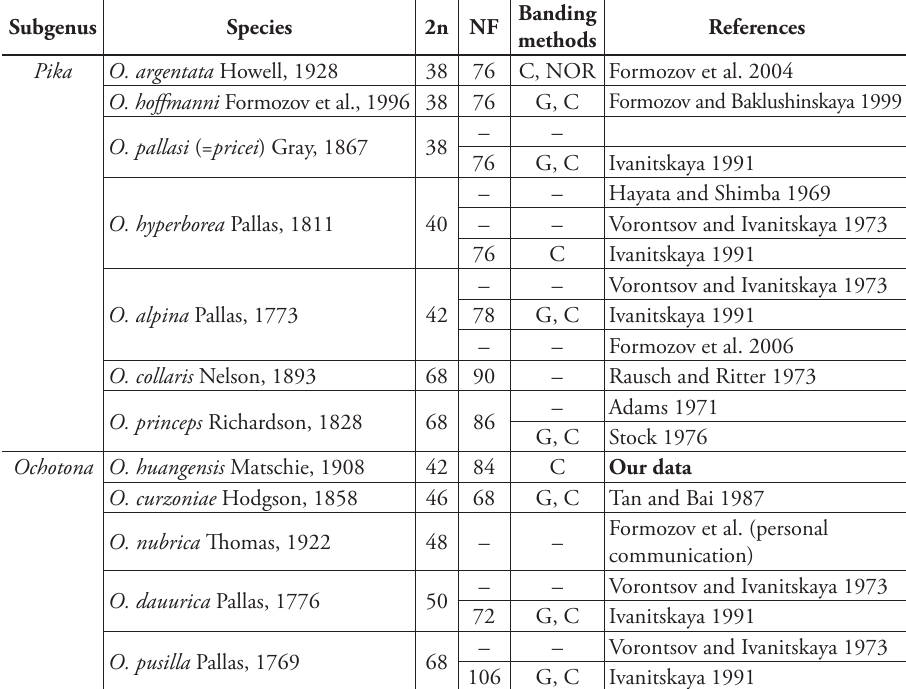
Table 1. Subgenera system of the genus Ochotona and variability of the diploid chromosome number (2n). NF – the fundamental number of chromosomal